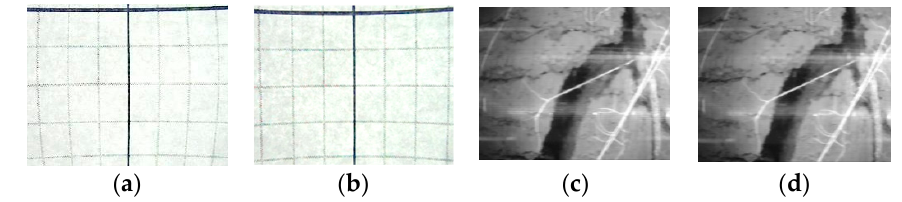
Figure 7. Applying Barrel distortion correction: ( a ) distortion profile, ( b ) corrected profile; ( c ) distorted image, and ( d ) corrected image after application.